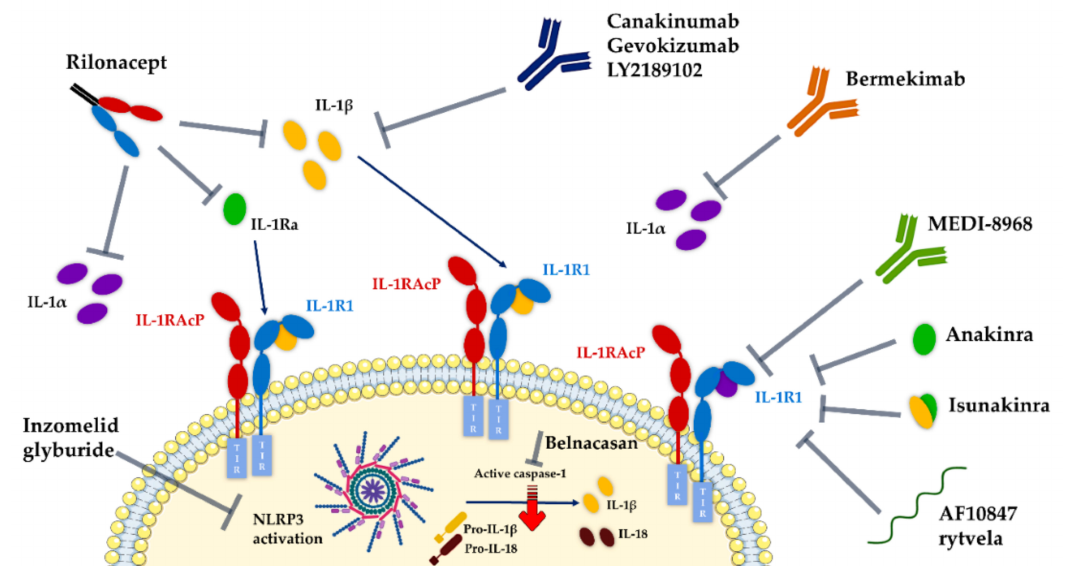
Figure 8. Main strategies targeting IL-1 signaling. Therapeutic approaches targeting IL-1R1 include a recombinant form of IL-1Ra (anakinra), a chimeric IL-1Ra-IL-1 β protein (isunakinra), a fully human monoclonal antibody (MEDI-896) and peptides AF10847 and rytvela. Rilonacept stands as an engineered dimeric fusion protein consisting of the ECDs of the human IL-1R1 and IL-1RAcP linked to the Fc portion of human immunoglobulin G1 (IgG1), acting as a decoy receptor, binding IL-1 α , IL-1 β and IL-1Ra. The monoclonal antibodies (mAb) antagonizing IL-1 β are canakinumab, gevokizumab and LYS2189102, whilst bermekimab works by blocking IL-1 α . The small molecules inzomelid and glyburide directly inhibit NLRP3 inflammasome activation, while belnacasan specifically inhibits caspase-1 and consequently the maturation of pro-IL-1 β into the respective active form. The figure was prepared using BioRender. Adapted from [243]. Figure abbreviations: IL-1, interleukin-1; IL-1R1, interleukin-1 receptor type 1; IL-1Ra, interleukin 1 receptor antagonist; IL-1RAcp, interleukin-1 receptor accessory protein; TIR domain, the toll-interleukin-1 receptor homology domain; NLRP3, NLR family pyrin-domain-containing